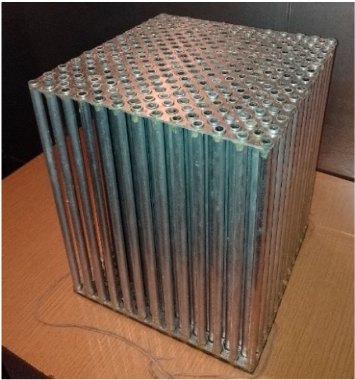
Figure 5. Heat exchanger 1 made of cylinders with an external diameter of 10 mm and a wall thickness of 1